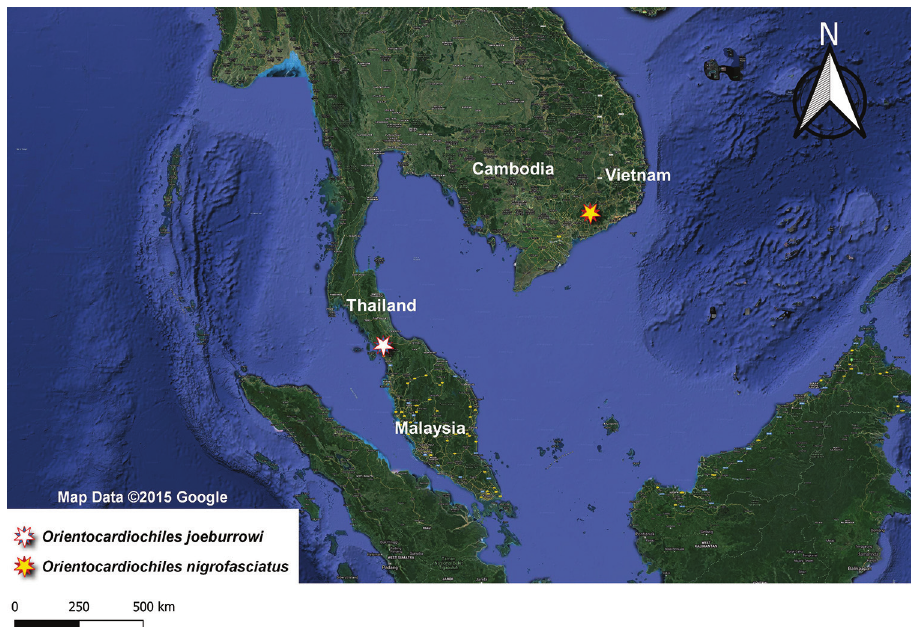
Figure 3. Distribution map of the members of Orientocardiochiles gen. nov. in Malaysia and Vietnam.